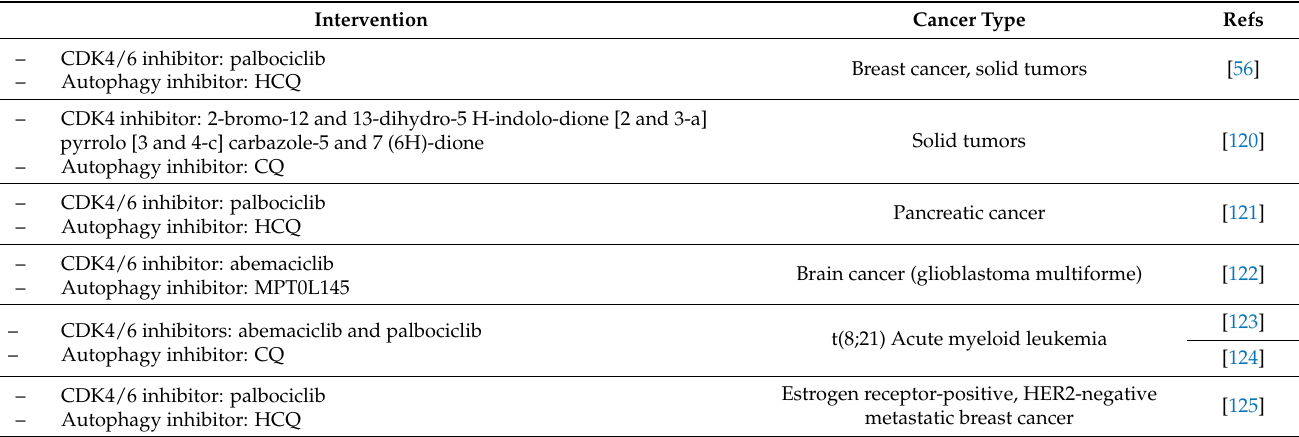
Table 1. Combination therapies of cell-cycle inhibitors and autophagy inhibitors. CQ: chloroquine; HCQ: hydroxychloroquine.